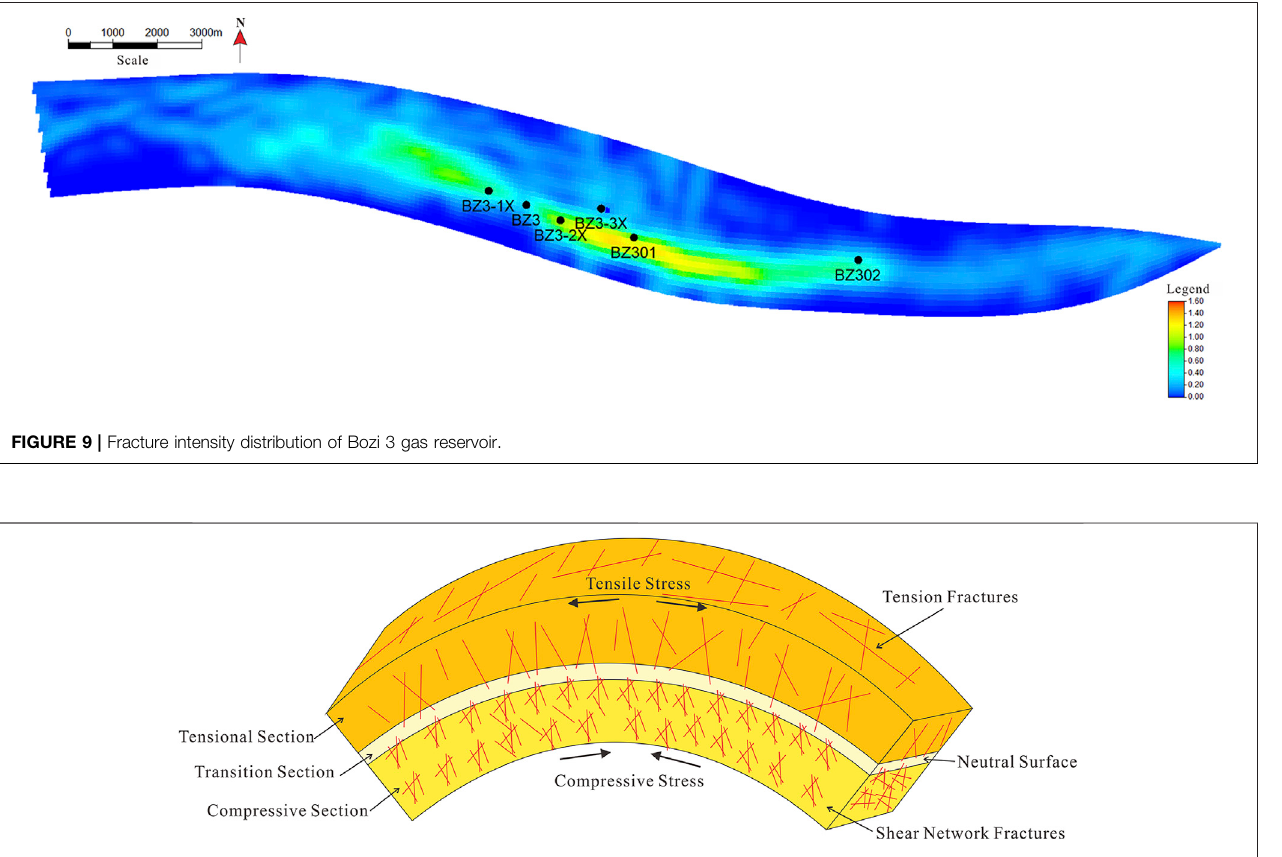
FIGURE 10 | Fracture patterns in different stress